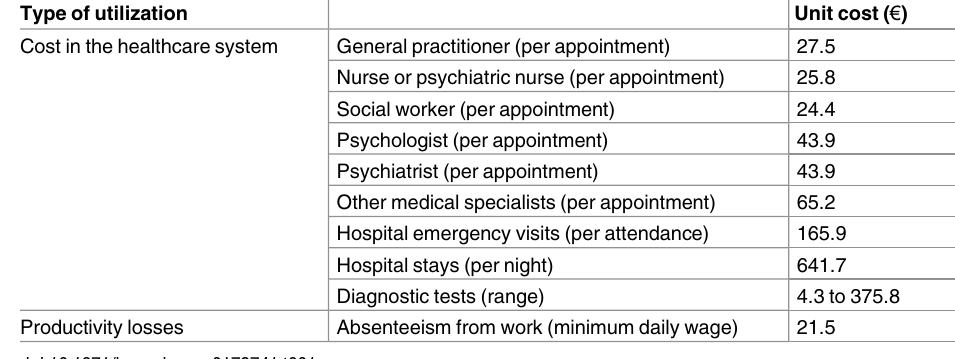
Table 1. Unit costs used in the calculation of direct and indirect costs (financial year 2014; values in € ). Type of